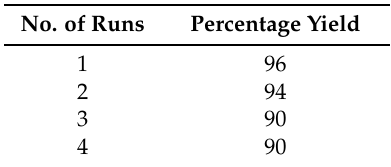
Table 4. Reusability of β -CD-PSA as catalyst for 5a .